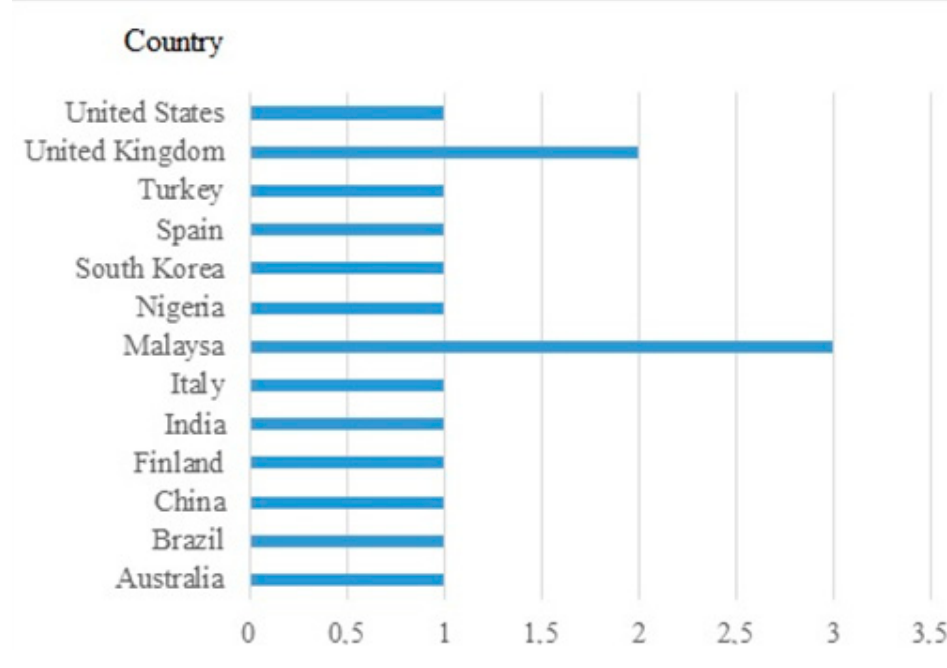
Figure 3. Distribution of publications by country.